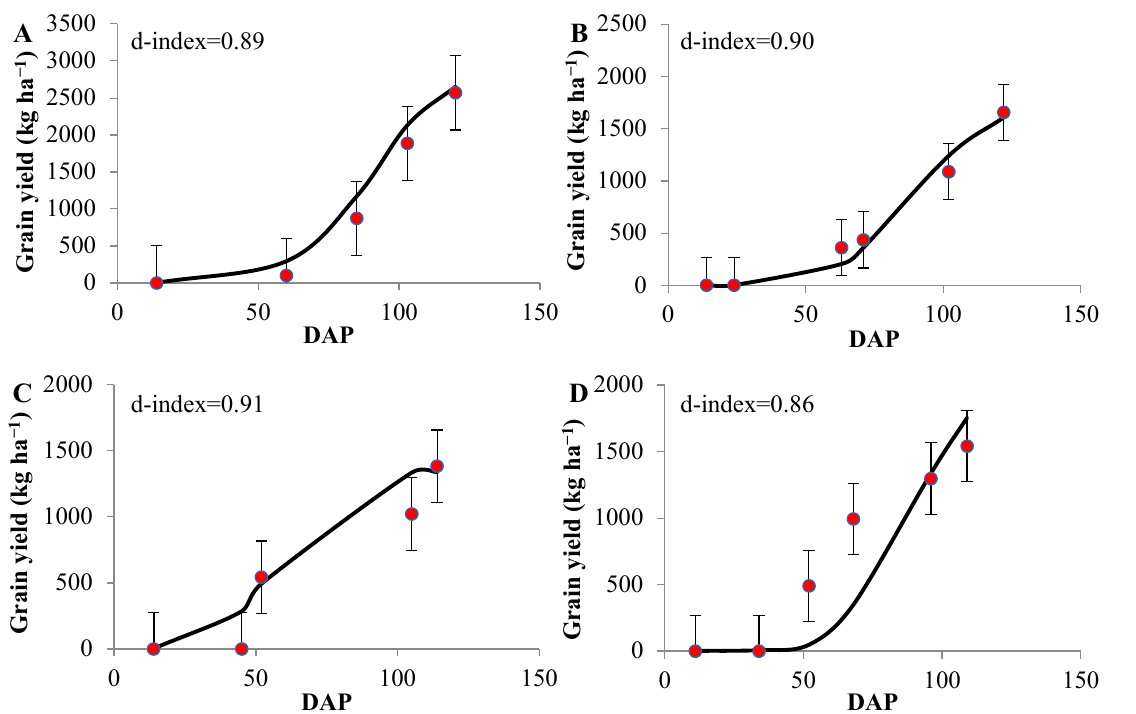
Figure 3. Simulation (lines) and measurement (symbols) of grain yield for oilseed flax cultivar Longya Hybrid No. 1 grown in Dingxi ( A ) and in Wulanchabu ( C ); Baxuan No. 3 grown in Zhangjiakou ( B ); and Zhangya No. 2 grown in Datong ( D ). Table 5. Statistical summary for calibration of the SIMPLE-Flax model.